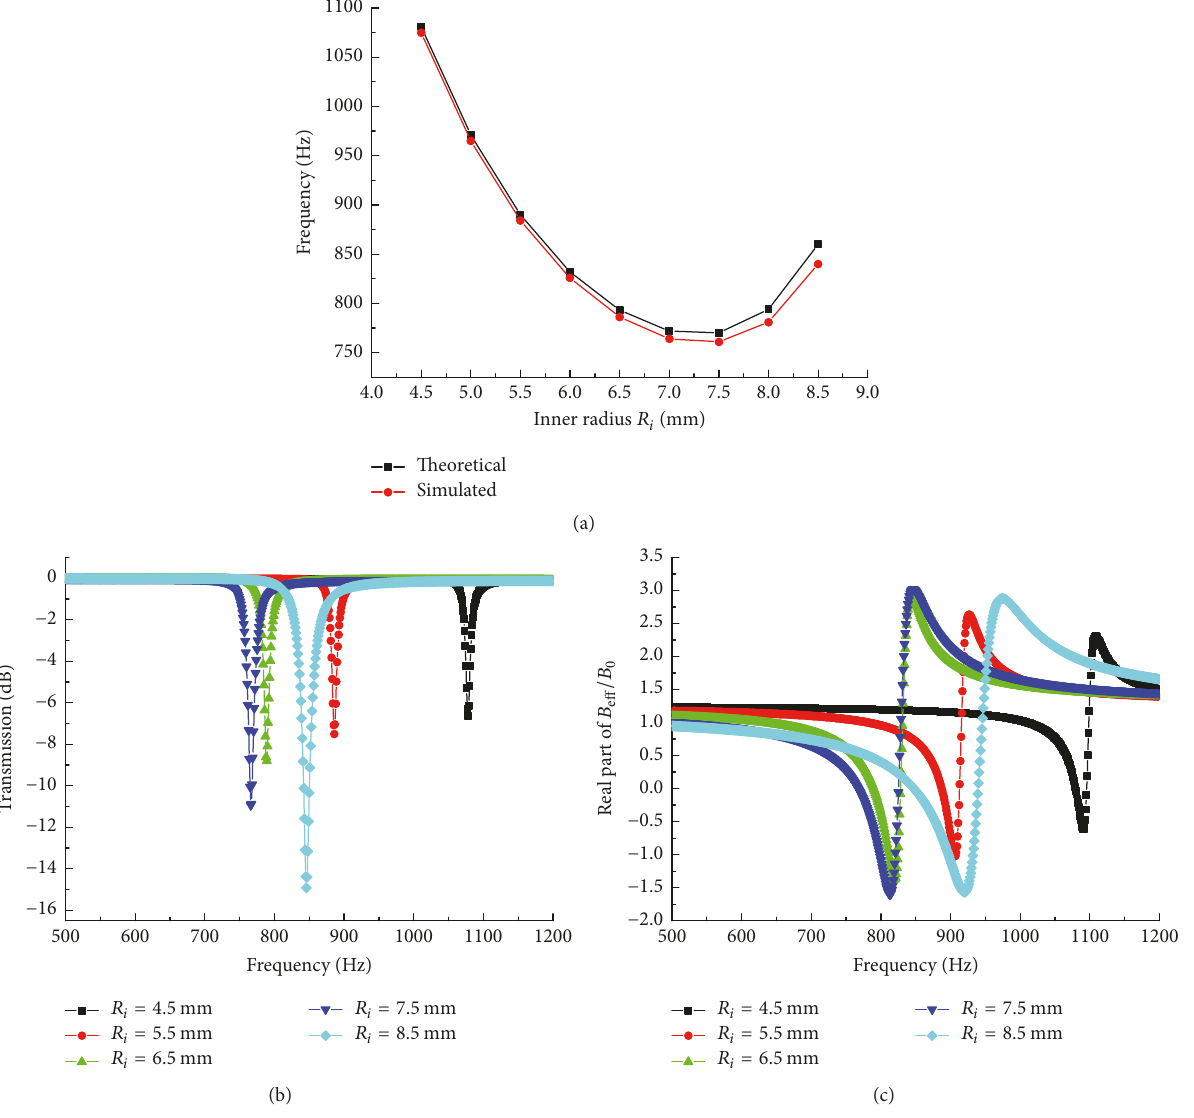
Figure 7: The relation curves present the relationship between the inner radius and related parameters ( 𝑅 𝑜 = 9.0 mm, 𝑎 = 0.5 mm). (a) The resonance frequency of SHS. (b) The transmission coefficient. (c) The effective